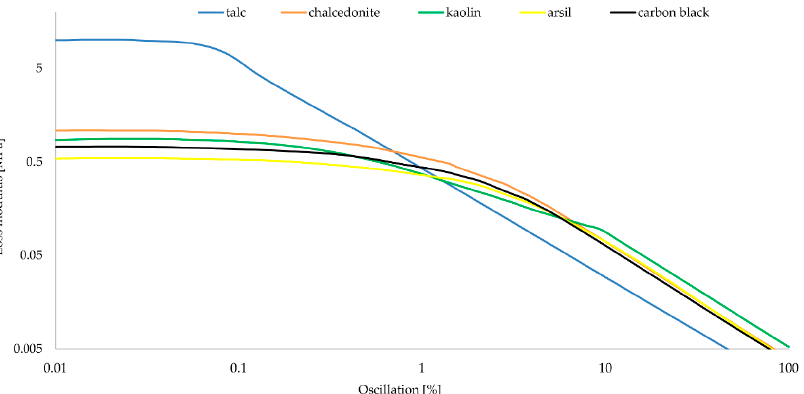
Figure 7. Loss modulus of filled CSM43; T = 160